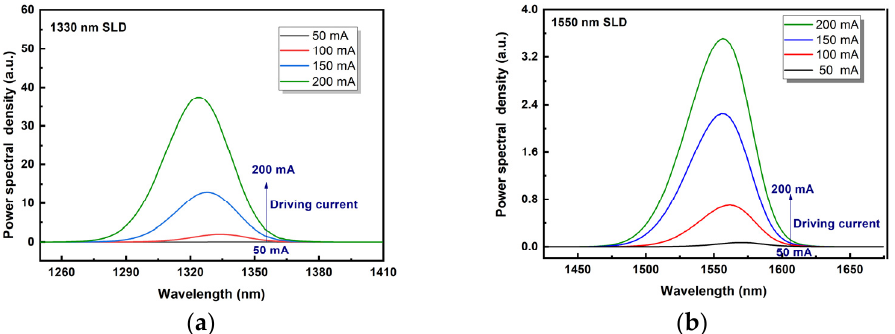
Figure 9. Output spectra of the two SLDs with central wavelengths of ( a ) 1330 nm and ( b ) 1550 nm under different driving currents.